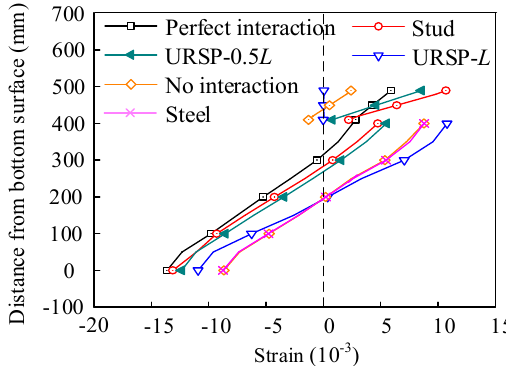
Figure 11. Strain distribution along the section height.